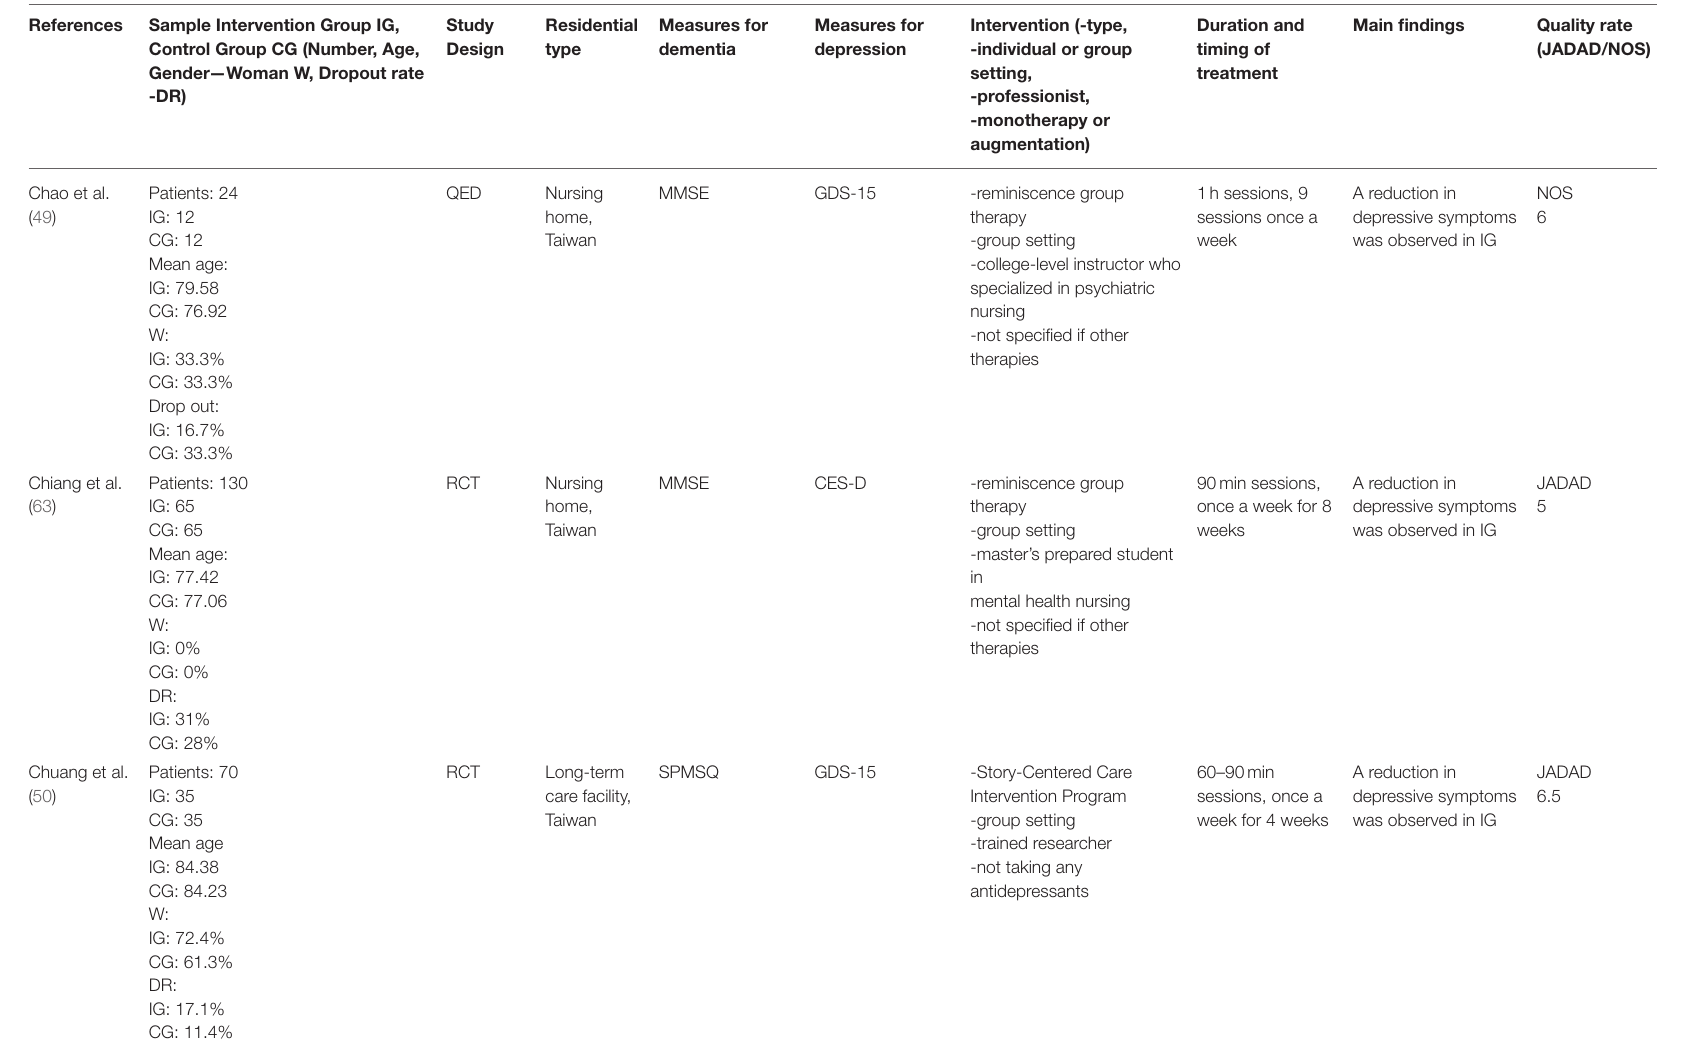
TABLE 6 | Reminiscence and Story Sharing studies (n 14